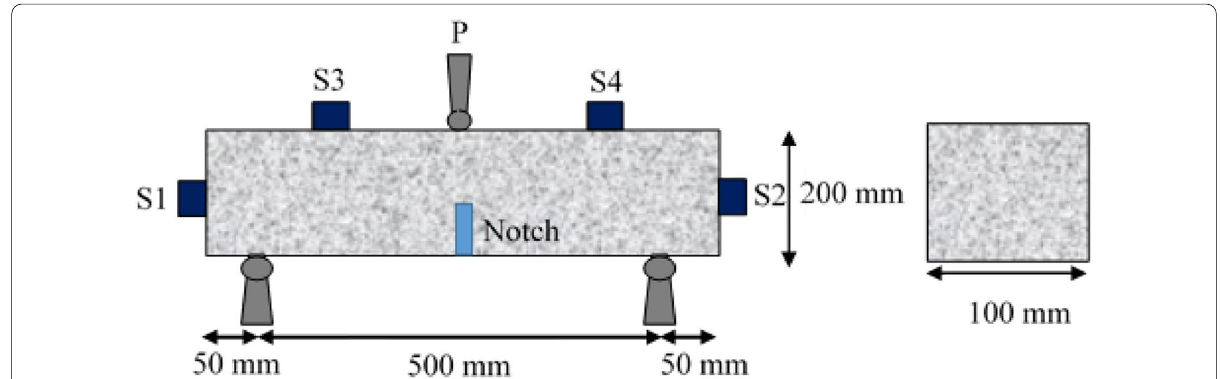
Fig. 2 Setup of the instrument for three-point bending